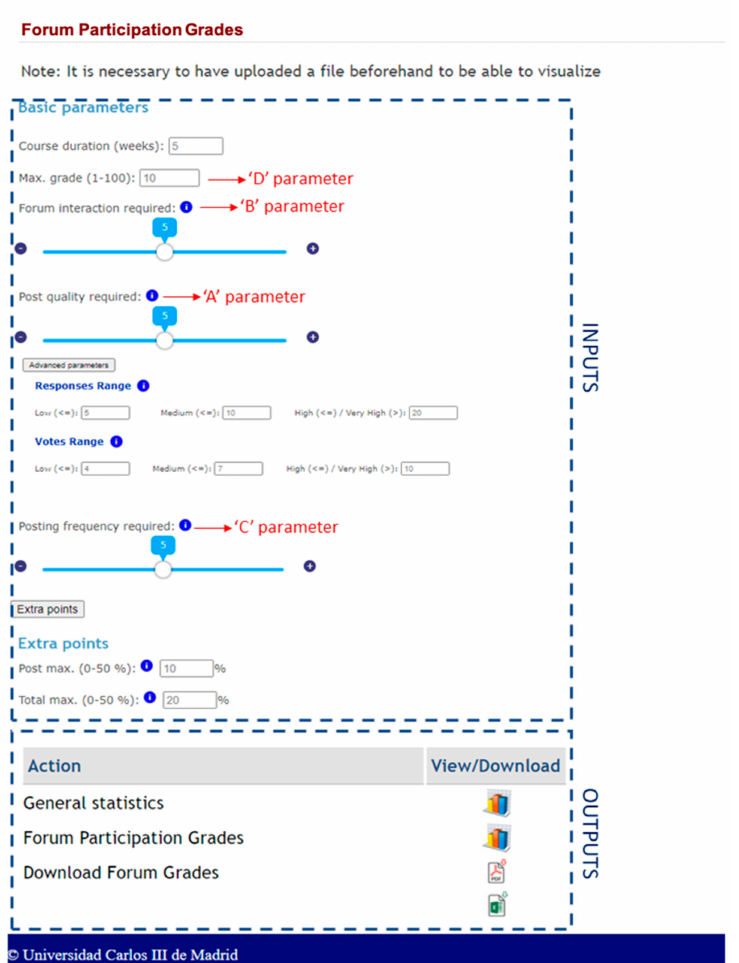
Figure 6. Screenshot of the web application with the functionality to implement the grading algorithm with the two key parts: (1) inputs, and (2)